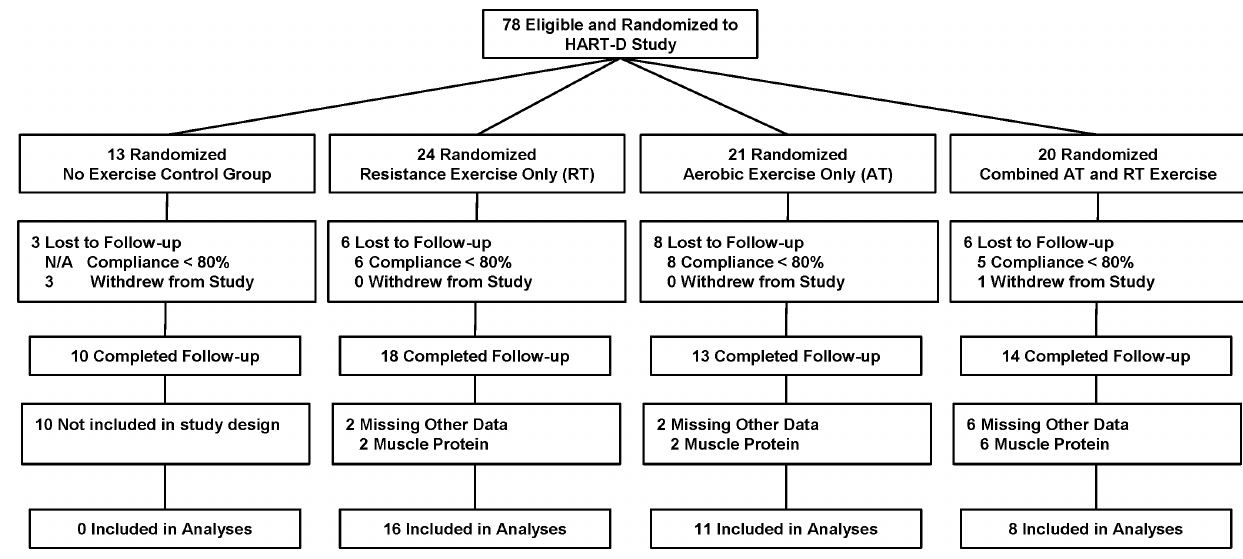
Figure 1. Consort diagram.